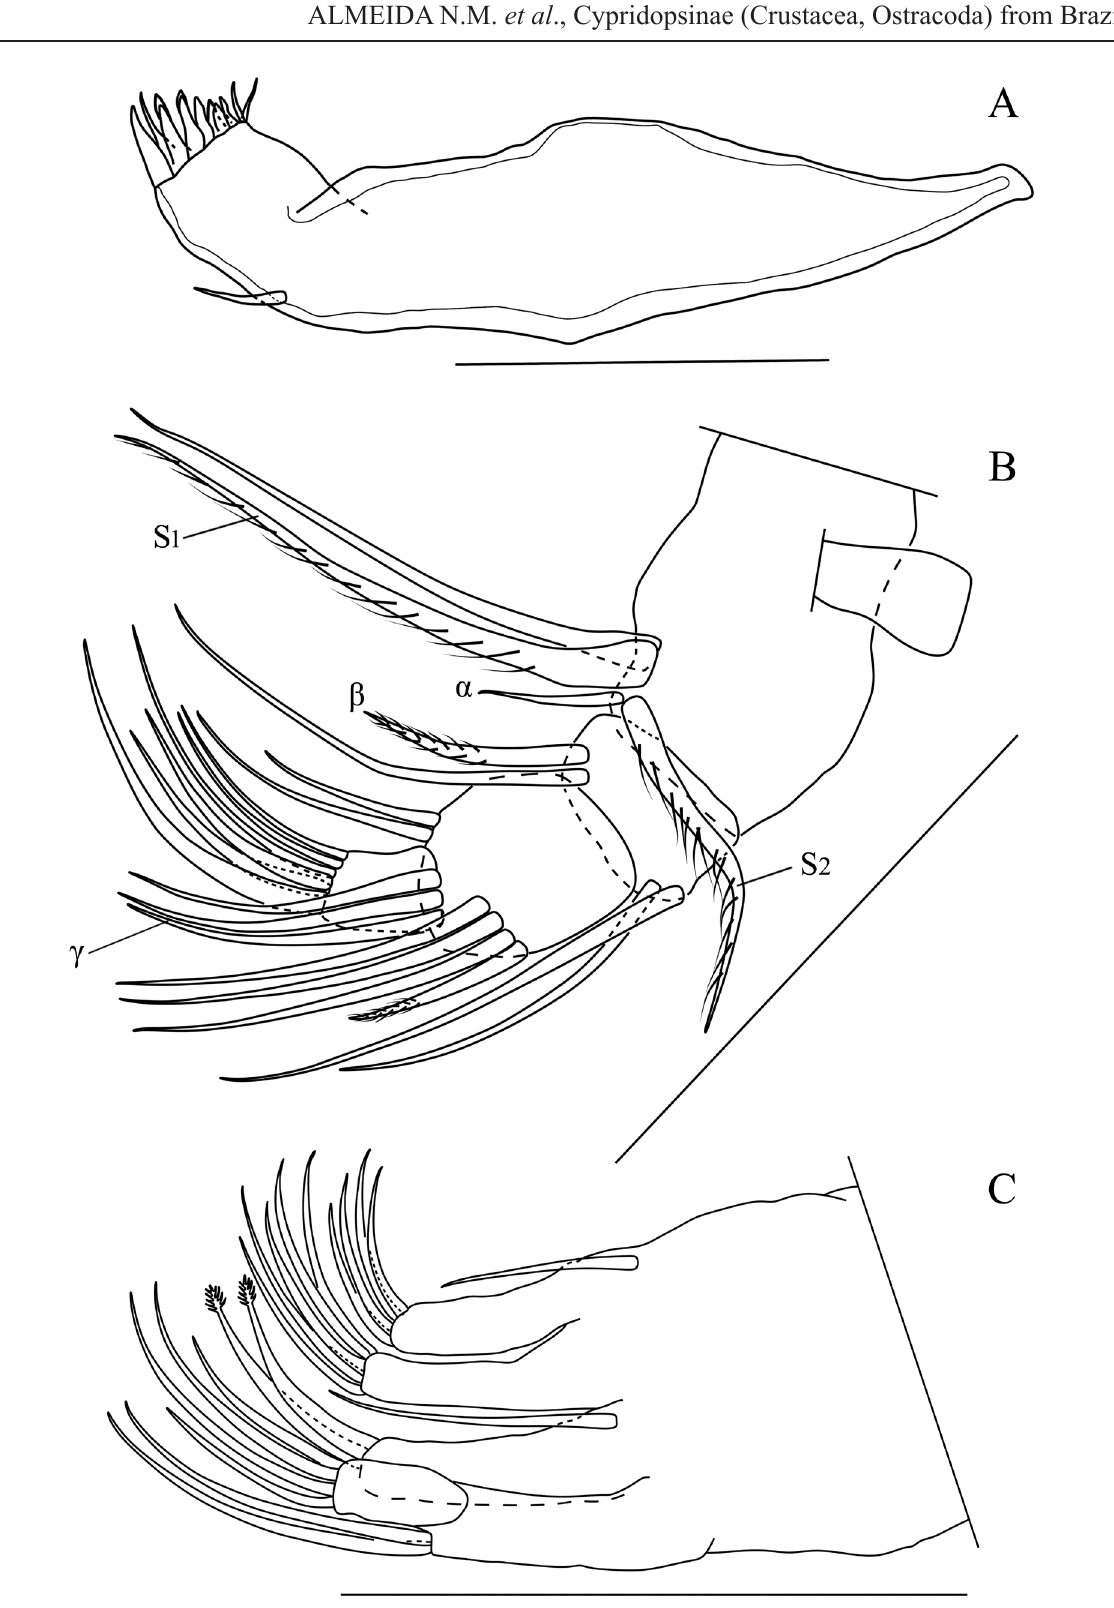
Fig. 20. Paranadopsis reducta gen. et sp. nov. from the Upper Paraná River floodplain, ♀. A . Md (MZUSP 41869). B . Md-palp (MZUSP 41867). C . Mx1 (MZUSP 41867). Abbreviations: see text and Material and methods. Scale bars: